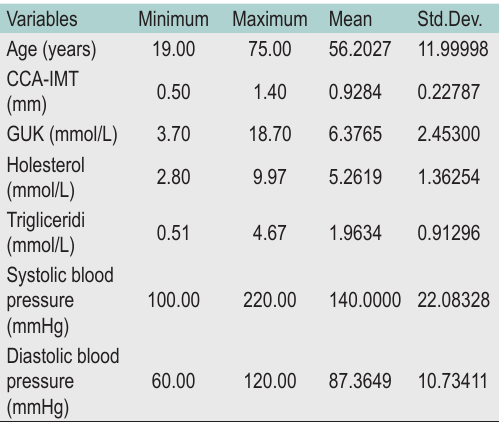
TABLE 1. Baseline characteristics of the study population